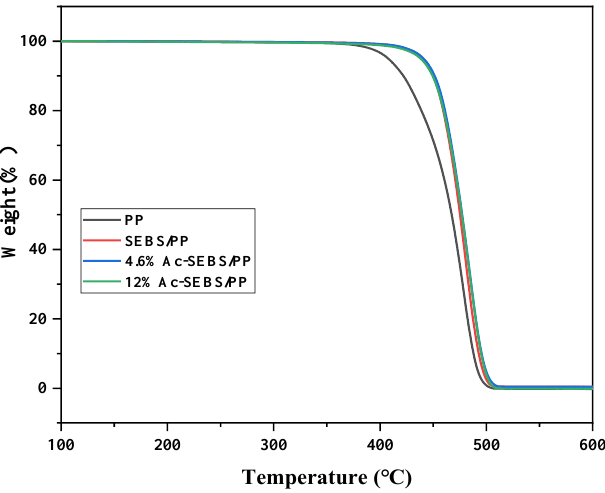
Figure 5. Thermogravimetric curves curve of PP and its blends.